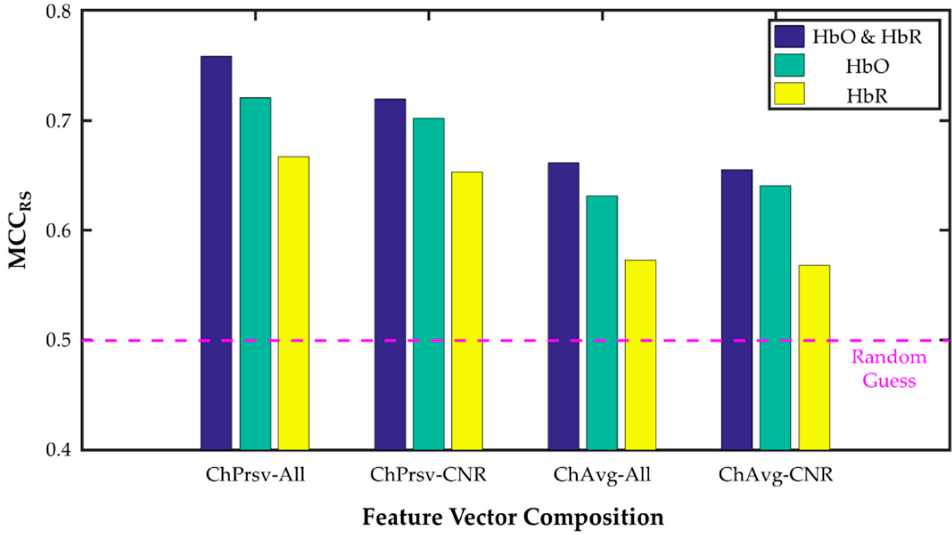
Figure 4. MCC RS Comparison according to feature vector compositions. MCC RS (seven participants) results are displayed after being grouped. ChPrsv means ‘channel-preserving, and ChAvg means ‘channel-averaging’. All indicates ‘using all channels’, whereas Contrast-to-Noise Ratio (CNR) means ‘CNR-selected’. The values used for the bar graph are accessible in Table S1 (Supplementary